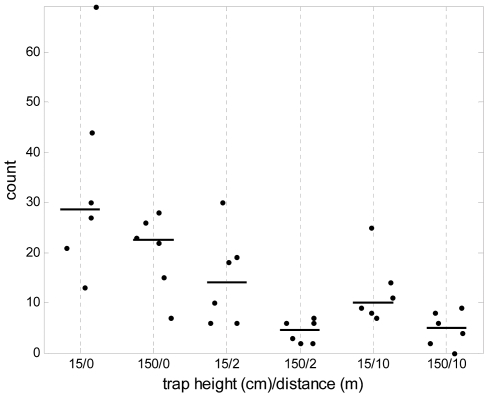
Malaria vector data from Experiment 3.Numbers of female An. gambiae s.l. mosquitoes collected in CO2 and human odour-baited MM-X traps in an experiment of different trap heights (height in cm of the bottom of the trap containing the opening) and distances away from the huts (in metres, m). Horizontal bars show the count per trap for each treatment group.